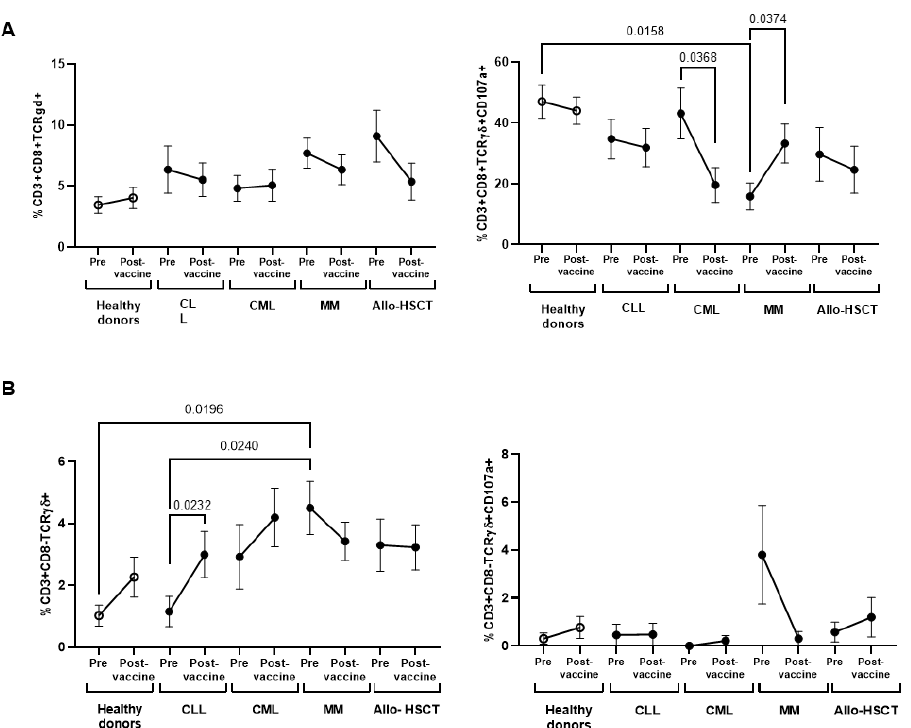
Figure 6. Characterization of CD3+CD8 ± TCR γδ + cells in PBMCs from individuals with OHD before and after receiving one-dose vaccination. ( A ) CD3 + CD8 + TCR γδ + cell count ( left graph ) and expression of CD107a in these cells ( right graph ) was determined in PBMCs from individuals with OHD, in comparison with healthy donors. ( B ) CD3 + CD8 - TCR γδ + cell count ( left graph ) and expression of CD107a in these cells ( right graph ) was determined in PBMCs from individuals with OHD, in comparison with healthy donors. Each dot in the graphs corresponds to mean ± SEM. Statistical significance between groups was calculated using one-way ANOVA test and statistical significance within groups was calculated using Mann – Whitney test.